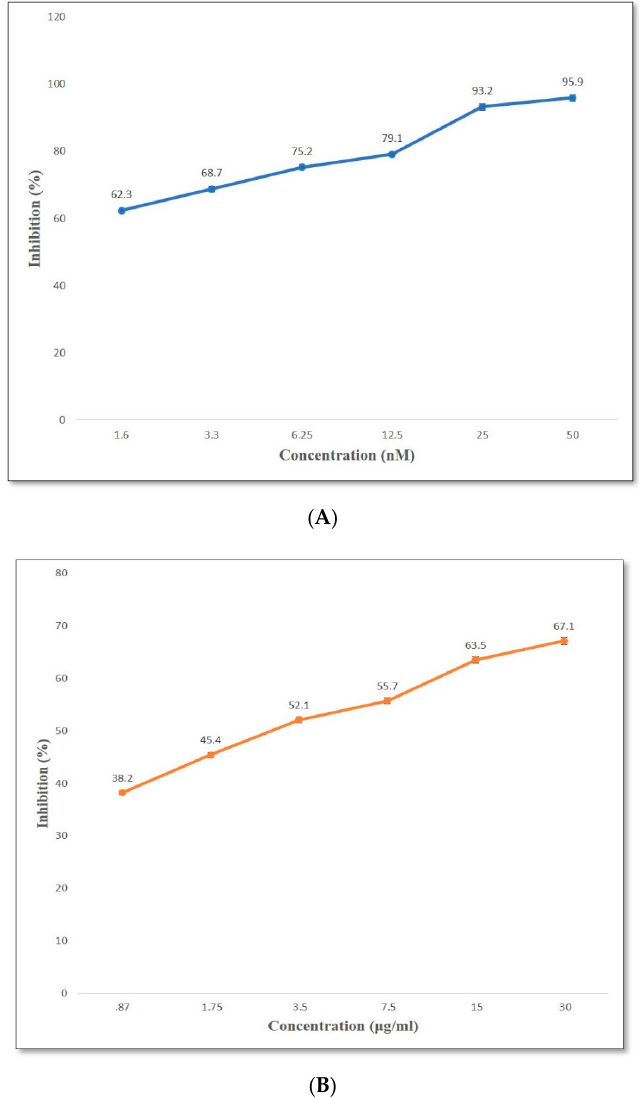
Figure 5. ( A ) Inhibition ofDPP-4 free radicals by an ascending concentration (nM) of sitagliptin. ( B ) Inhibition of DPP-4 free radicals by an ascending concentration (µg/mL) of DBT34 microbial extract. ( B ) Inhibition of DPP-4 free radicals by an ascending concentration ( µ g / mL) of DBT34 microbial